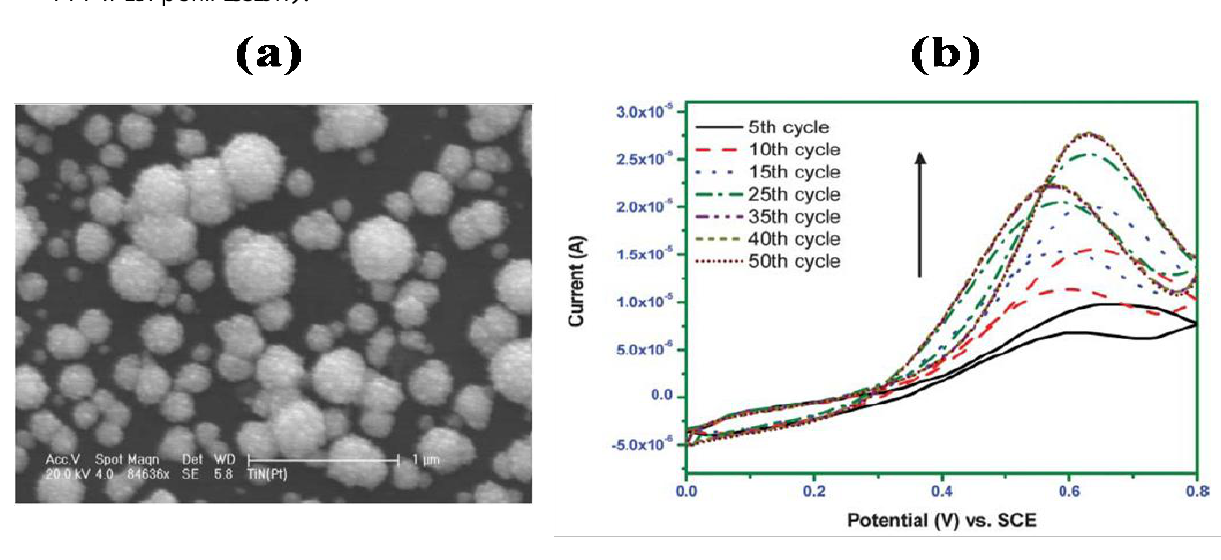
Figure 13. (a) SEM image and (b) Cyclic voltammograms of Pt–TiN for methanol oxidation in 0.5 M CH OH and 0.5 M H SO obtained by repeated cycles (Reprinted from Reference 3 2 4 111 with